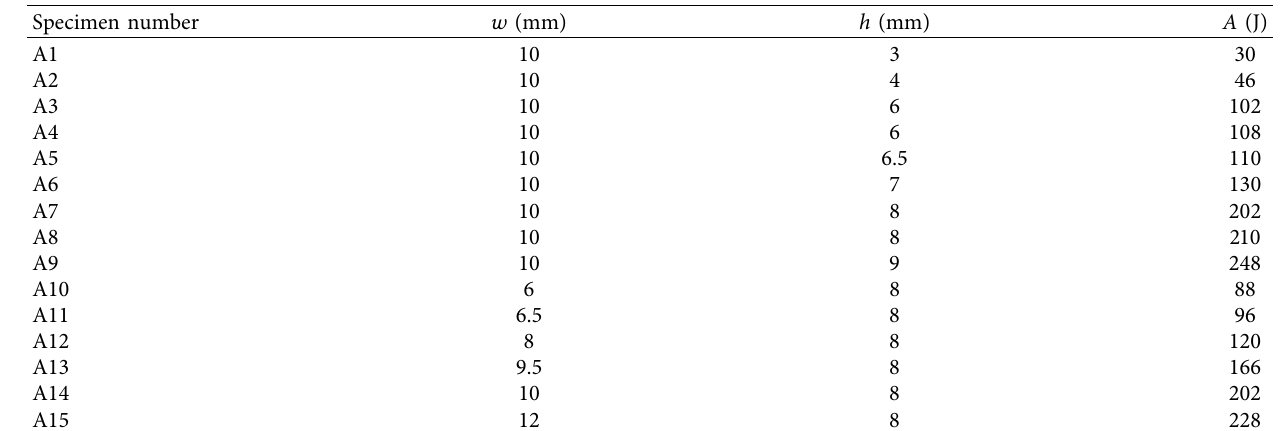
Table 2: Impact test results of 921A steel.